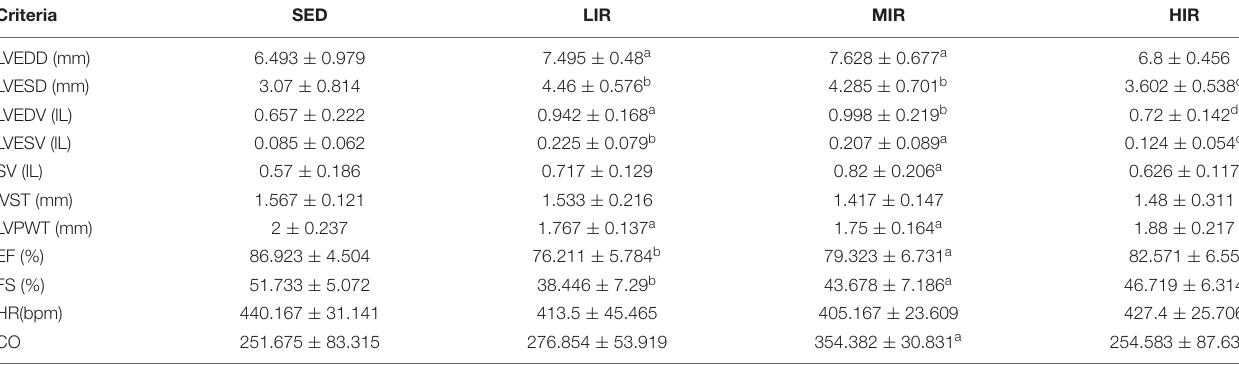
TABLE 2 | Echocardiographic analysis of SD rats subjected to different treadmill running intensities for 1 week. Criteria SED MIR